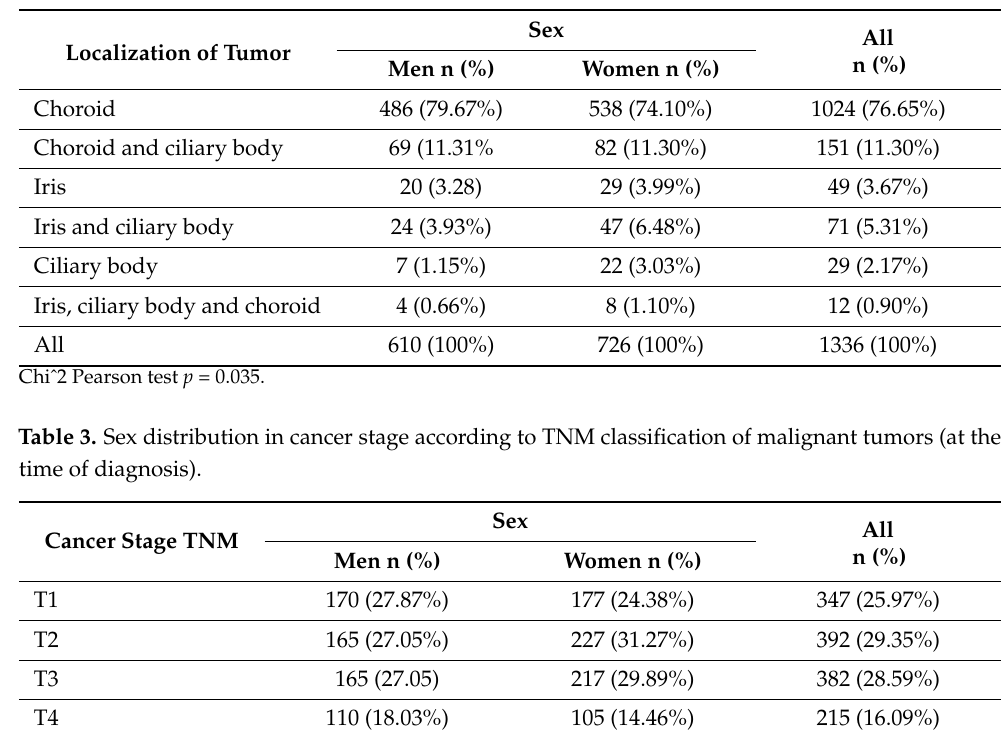
Table 2. Localizations of uveal melanoma according to sex of patient.